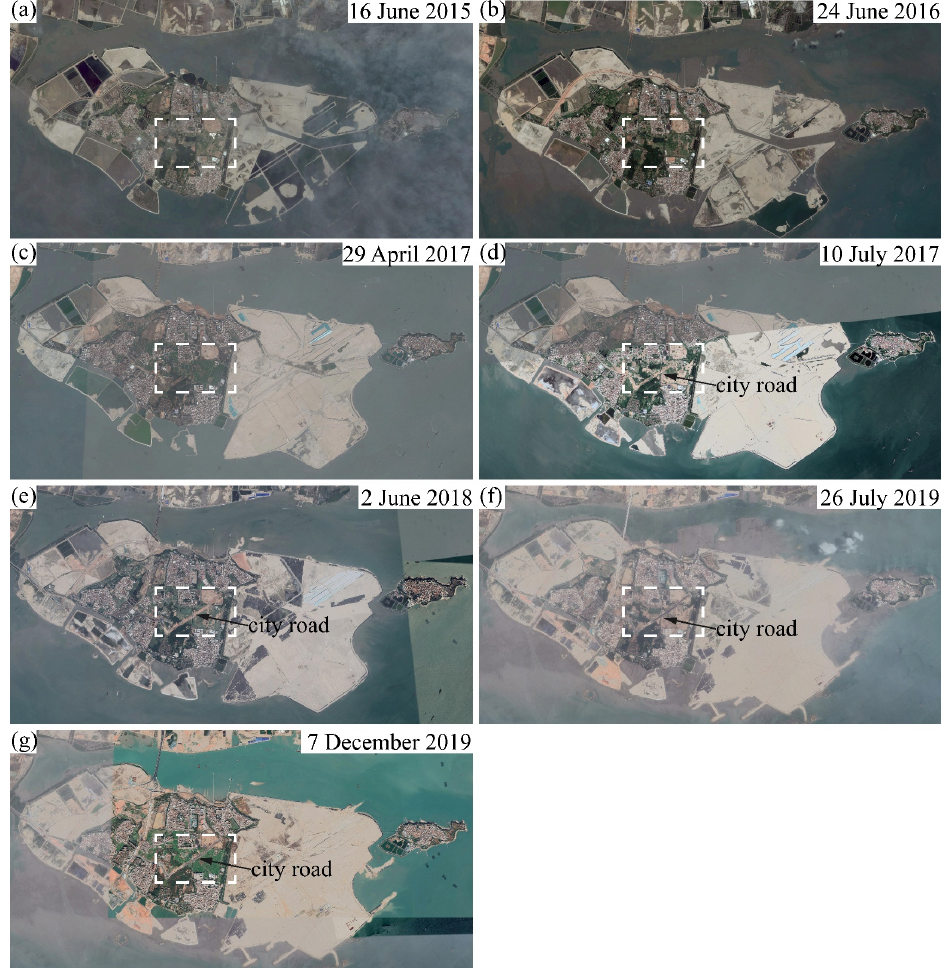
Figure 12. Optical images of the study area acquired on ( a ) 16 June 2015, ( b ) 24 June 2016, ( c ) 29 April 2017, ( d ) 10 July 2017, ( e ) 2 June 2018, ( f ) 26 July 2019, and ( g ) 7 December 2019. Area B was reclaimed in the second phase. Most of this region, except for the north- east part, needs two to ten years to consolidate. The northeast part was reclaimed before 13 April 2015, when the reclamation of the rest part of area B had not yet started (Figure 12). Therefore, when settlement in the northeast part ends, the remaining part of area B may still be in the primary consolidation stage or secondary compression stage. Similarly, areas C and E have varying consolidation times over different parts. Area D was reclaimed in the first phase, but its northern and southern parts had dif- ferent deformation rates (Figure 3). The southern part needs 4 to 10 years for consolida- tion. The northern part needs a shorter time to consolidate, and some parts have stopped subsiding. The first phase of the reclamation project was from March 2014 to 16 June 2015. As shown in Figure 11e, during the foundation treatment, different types of landfill ma- terials were used in the north and south. The different landfill materials led to the different remaining settlement times. In foundation treatment and engineering construction, special attention should be paid to the areas that need long consolidation times. However, it is worth noting that the prediction method used in this study may not be appropriate to predict the settlement in some parts of area A. Similar to the abovementioned description, farmland and some con- struction activity exist in area A (dry land of Dadeng Island). The subsidence patterns of farmland and some construction activity may be different from that of reclaimed areas.